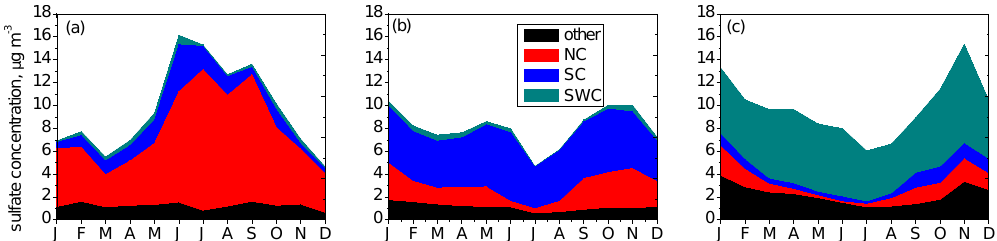
Figure 9. Monthly and regional mean sulfate concentrations over (a) NC, (b) SC, and (c) SWC, with contributions from within-region and inter-regional transport. Here “other” includes the rest of Chinese regions as well as foreign